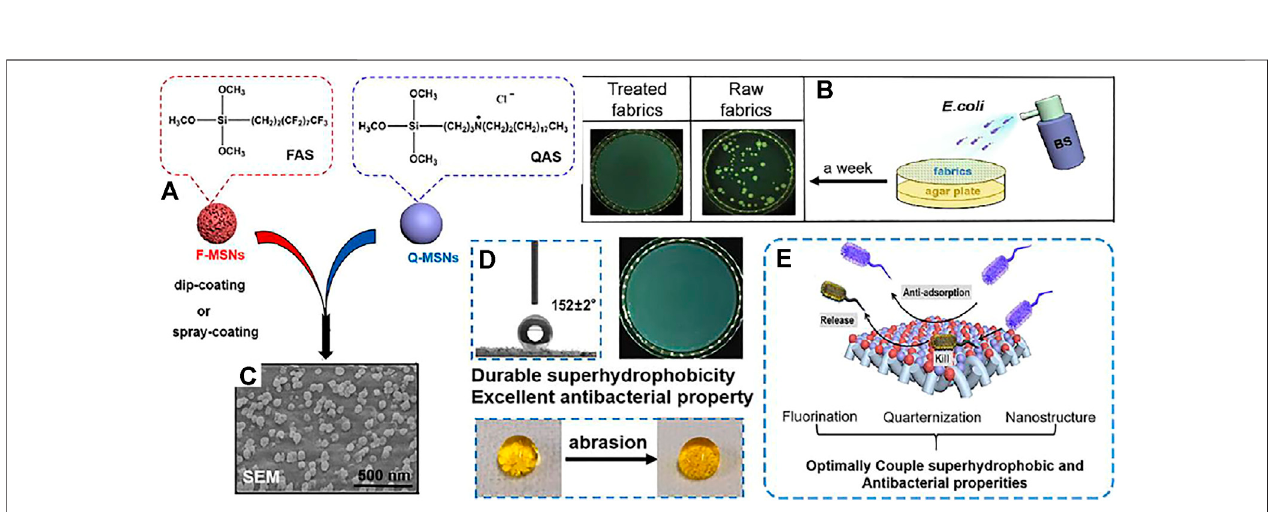
FIGURE 8 | (A) Schematic illustration of the con fi guring process of functionalized textiles. (B) Bacterial shielding experiments of cotton fabrics. (C) SEM images of the textiles. (D) Picture of a water drop (10 μ l) on the treated cotton fabrics surface before and after 600 abrasion cycles. (E) The schematic diagram of anti-bacterial action (Ye et al.,